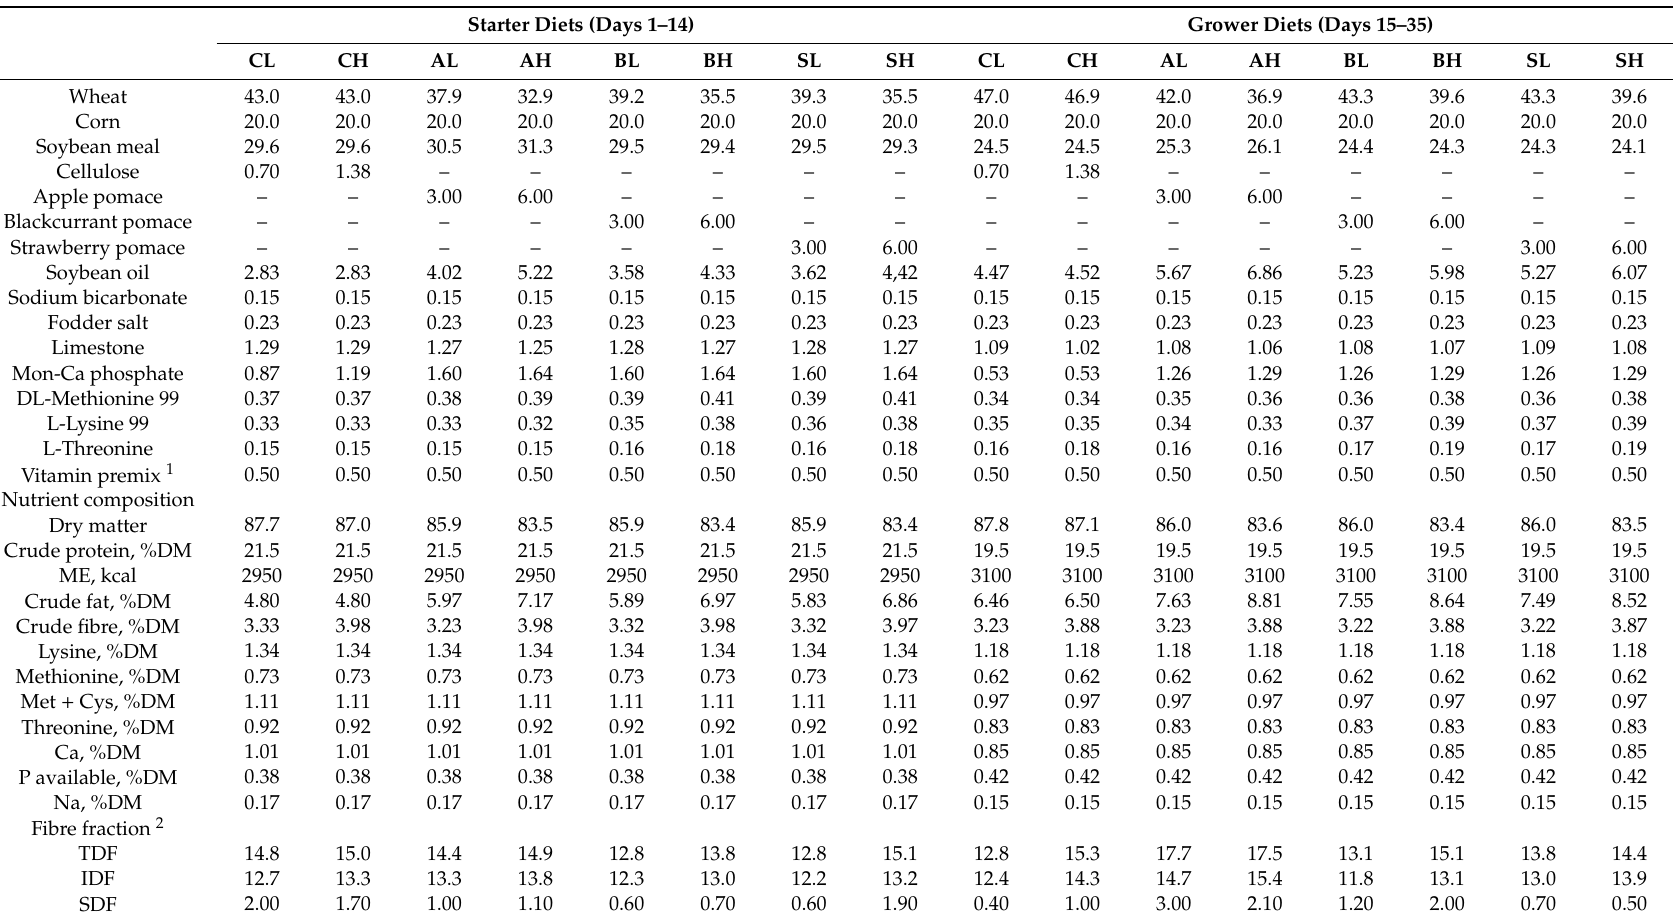
Table 1. Ingredients (%) and nutritional values of the experimental